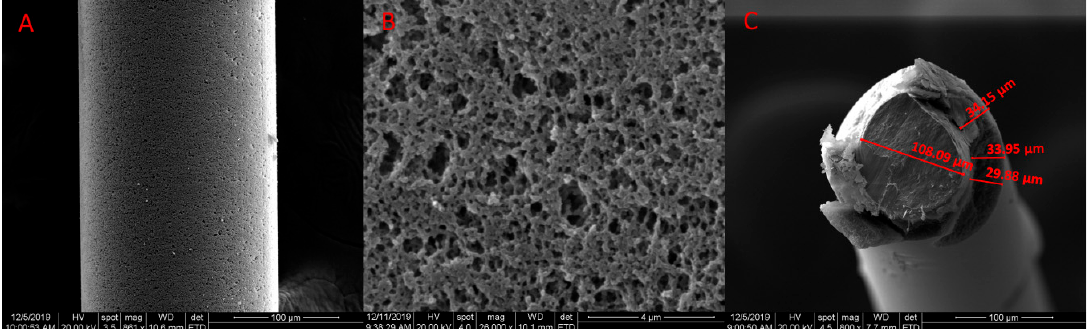
Figure 3. SEM images of the cross-linked PIL coating at the magnifications of ( A ) 861×; ( B ) 26000×, and ( C ) 800× cross-section view of the coating fiber.